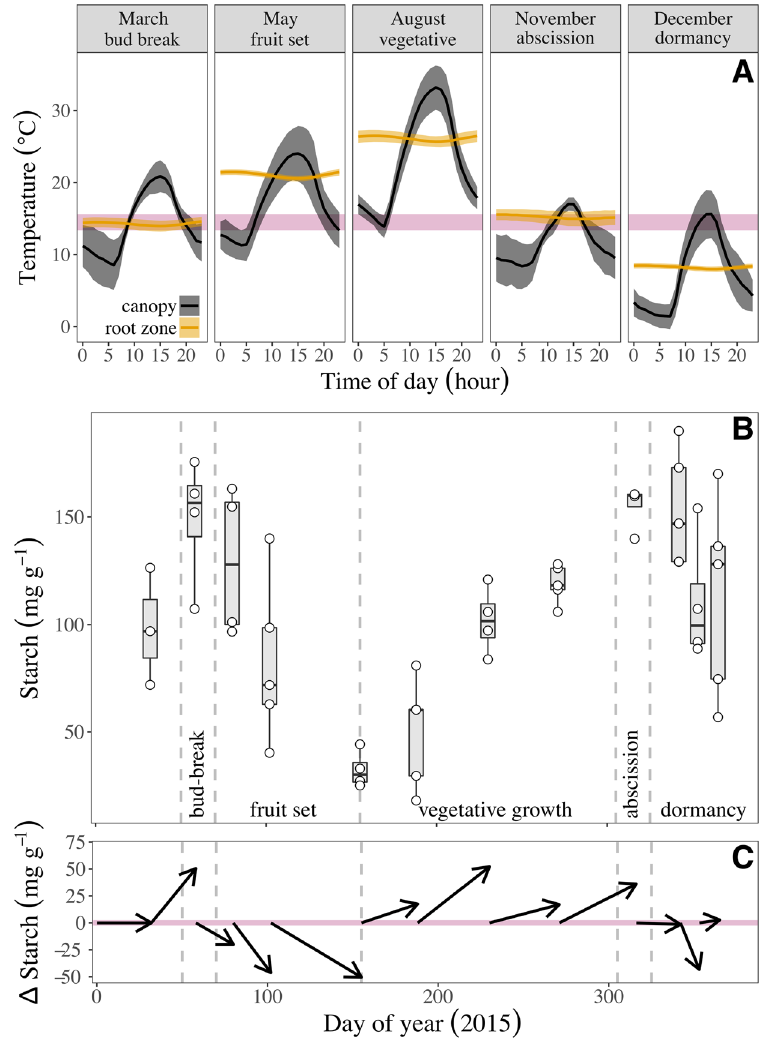
Figure 3. In - situ representation of seasonal changes in root-to-shoot temperature gradients and starch levels in the canopy of mature orchard trees. ( A ) Temperature variation and gradients during bud-break, fruit set, vegetative growth, abscission, and dormancy at the canopy (blue line, shaded area denotes SE values of 7 days) and in the roots zone (30 cm deep, red line and shade). Pink line represents the 14.5 °C compensation point (established in experiment #1 with the appropriate 95% confidence intervals). ( B ) Starch levels in one-year-old branches collected at 11:00 from 5 mature trees. Gray boxes denote the 95% confidence intervals, thick line in the box exhibits the average, and circles show the starch levels at each tree. Dashed vertical lines separate between the phenological stages. ( C ) A vector illustration to emphasize the magnitude and direction of starch dynamics in the branches at the different phenological